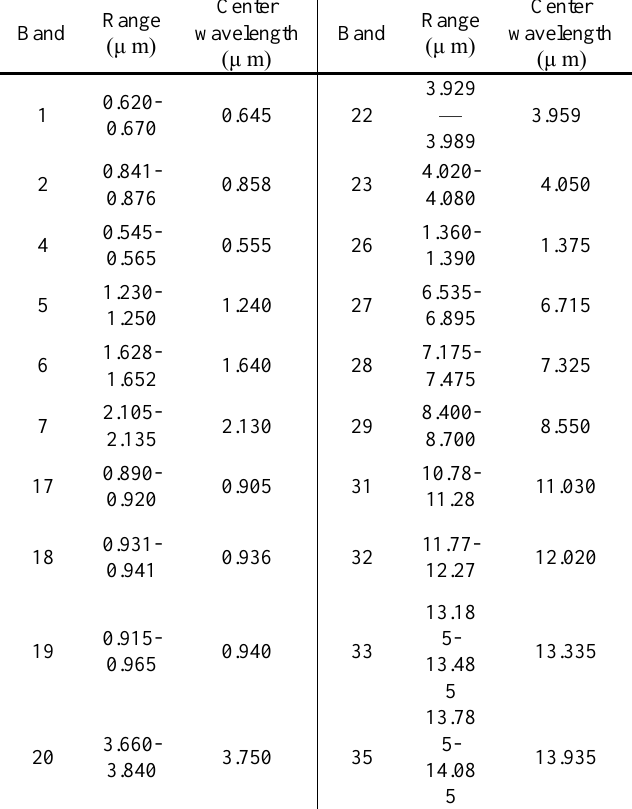
Table 3. Range and center wavelength of each channel used by MODIS for cloud